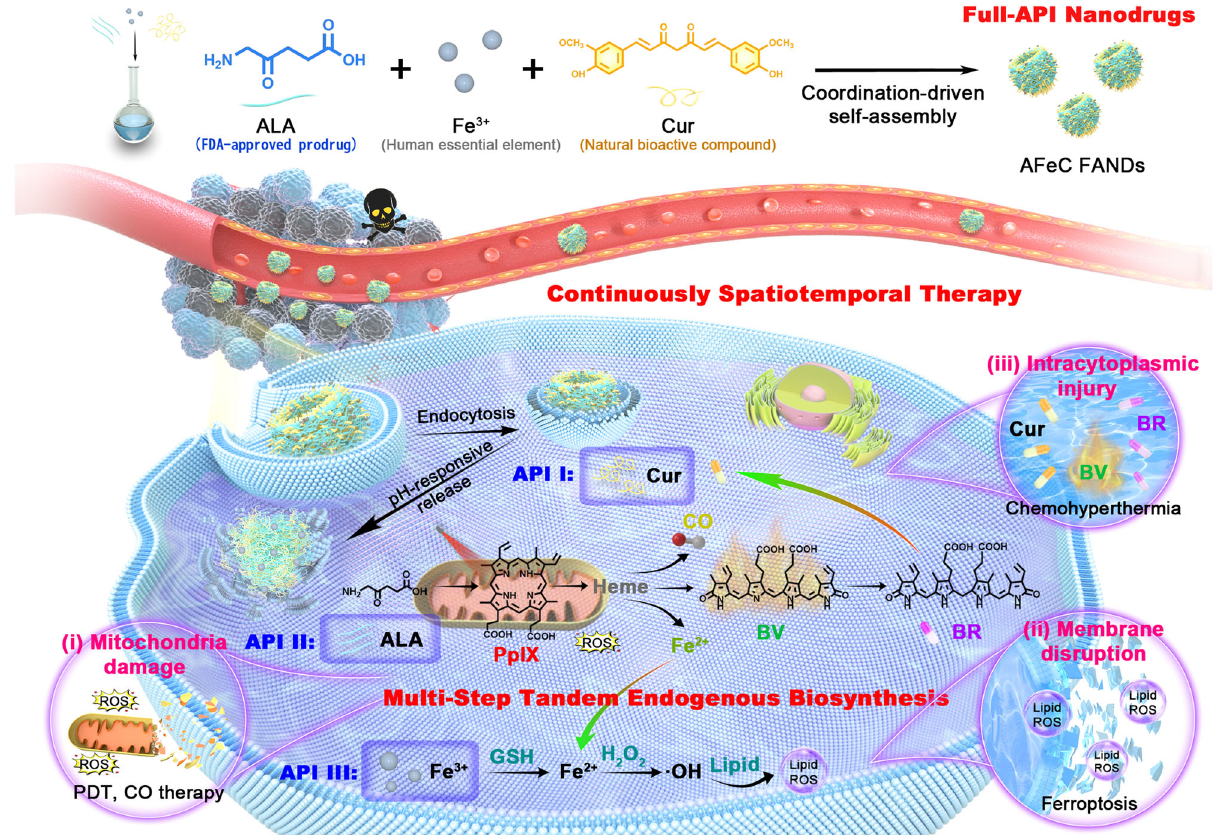
Fig. 1 | Schematic illustration of multi-step tandem endogenous biosynthesis triggered by the AFeC FANDs for continuous spatiotemporal cancer therapy. First, the Full-API nanodrugs consisted of FDA-approved ALA and Cur, as well as human essential Fe 3+ were fabricated by the metal coordination-driven self- assembly, which could accumulate at tumor sites via the enhanced permeability and retention (EPR) effect, and release active ingredients in acid tumor cells.